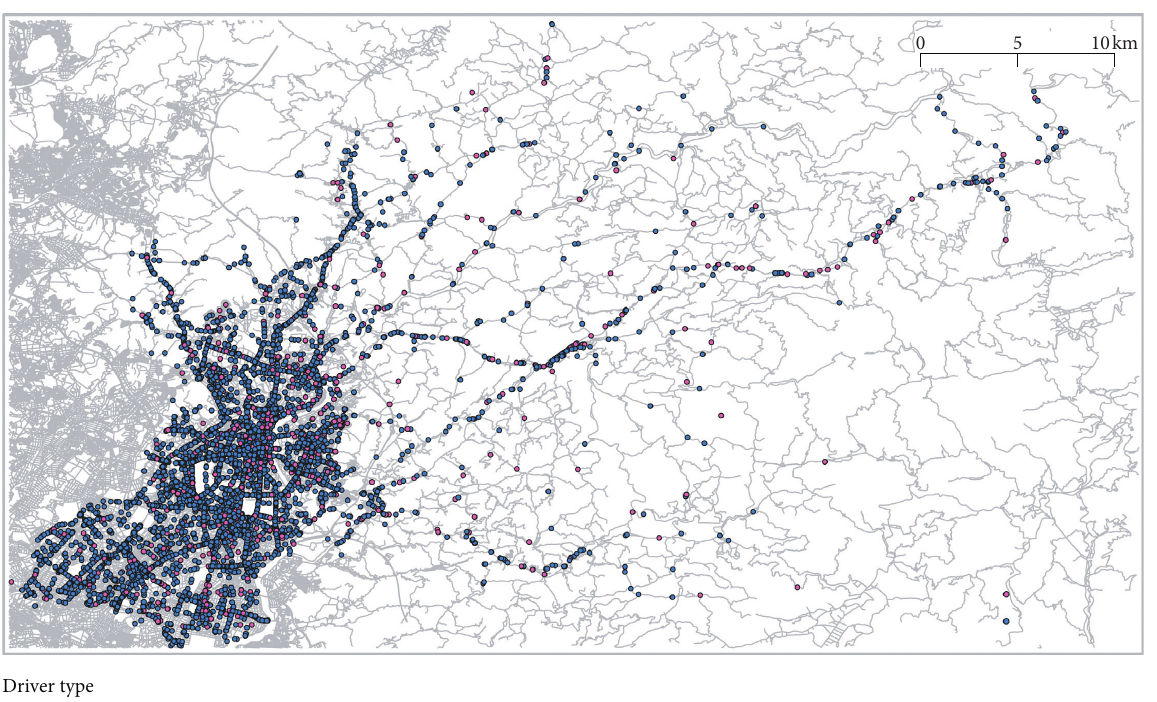
Figure 1: Vehicle crashes due to elderly and nonelderly drivers in Toyota